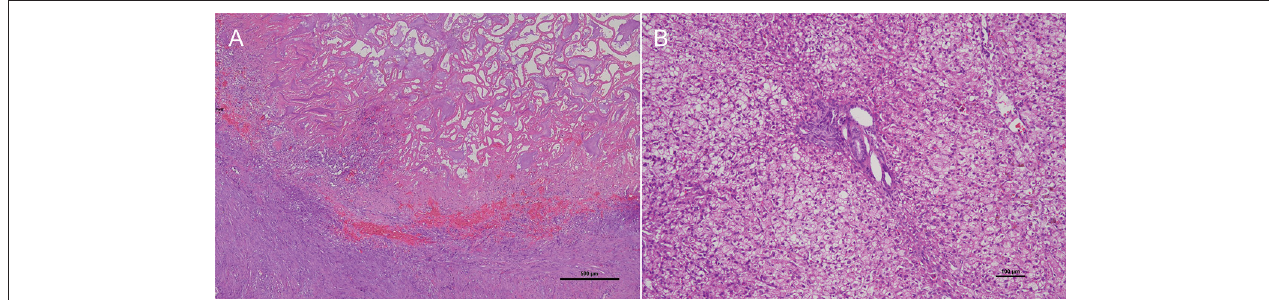
FIGURE 6 | Photomicrography of the hematoxylin and eosin-stained section of the gallbladder and liver. (A) A large viscous accumulation of mucus that filled and distended the gallbladder lumen and full thickness necrosis of the gallbladder wall. (B) Liver biopsy specimens revealed cytoplasmic vacuolation of hepatocytes without any inflammation and fibrosis of the hepatic